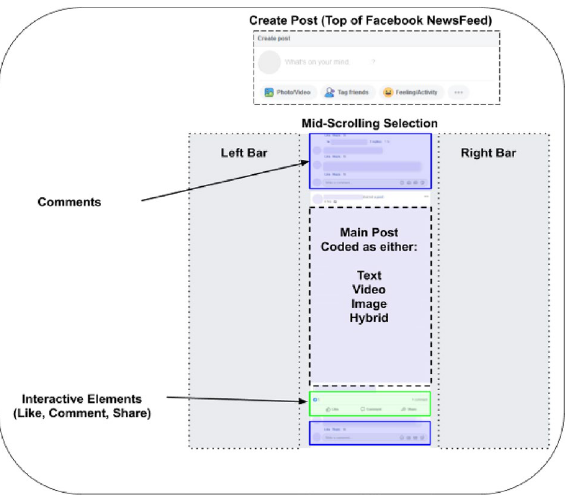
Figure 1. Labelling strategy for Facebook News Feed content. The content categories are ‘Create Post’, ‘Text Content’, ‘Image Content’, ‘Video Content’, ‘Hybrid Content’, ‘Interaction Elements’, ‘Comments’. Each denotes a unique type of content, and allows us to capture visual behaviour in response to this category of visual stimuli. Hybrid Content refers to text overlaid upon an image. Coloured overlays are illustrative and were not displayed to